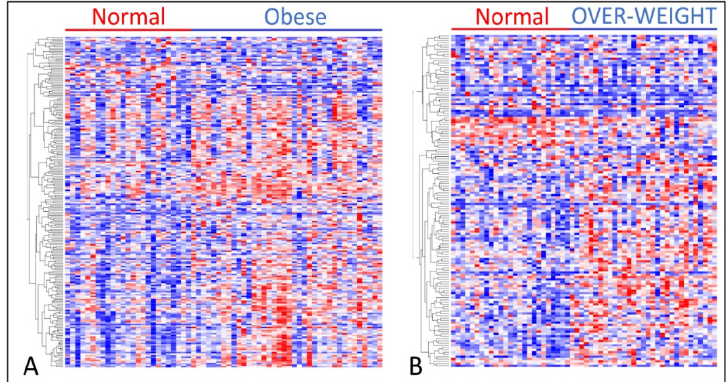
Figure 4. ( A ) Patterns of gene expression profiles for the 213 genes associating obesity with TNBC in postmenopausal women. ( B ) Patterns of gene expression profiles for the 146 genes associating overweight with TNBC in postmenopausal women. Genes in rows and patients in columns. Red color indicates upregulated and blue color indicates downregulated.